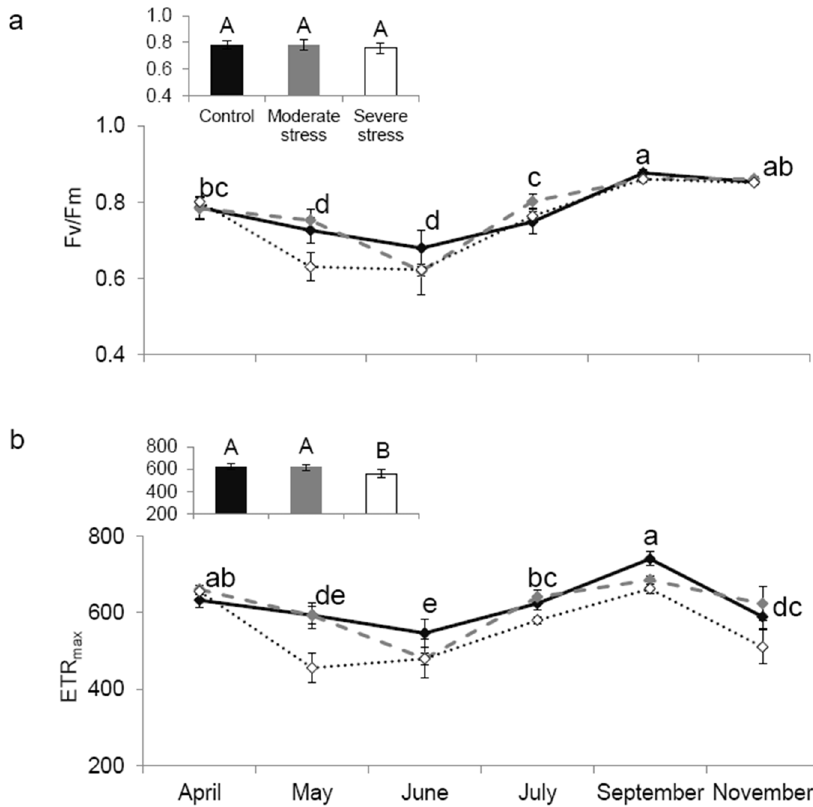
Figure 2. Chlorophyll fluorescence. Seasonal course of the variable to maximum fluorescence ratio (Fv/Fm, graph a) and maximal electron transport rate (ETR max , graph b) under control (– X –), mild ( ) and severe ( ??? e ??? ) water stress. Differences are tested using a two-way ANOVA repeated measures (F) followed by Tukey tests. Since interaction between seasonality and treatment is not significant according to the two-way ANOVA, results of water stress impact are shown in the small embedded graph where data of all months are pooled together and differences between treatments are denoted by capital letters (A . B) (similar capital letters indicate the absence of water stress influence) while seasonality impact is shown in the main graph (in lower case letters: a . b . c . d . e). Values are mean 6 SE of n=5.